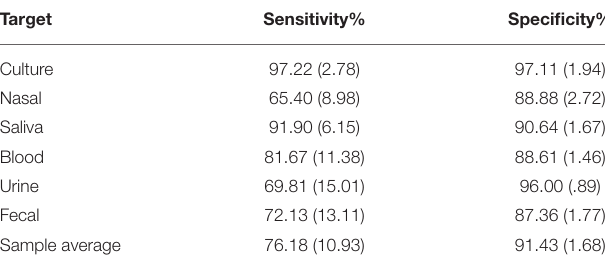
TABLE 3 | POCR testing results. Average ( ± SEM) sensitivity and specificity by dogs for each odor